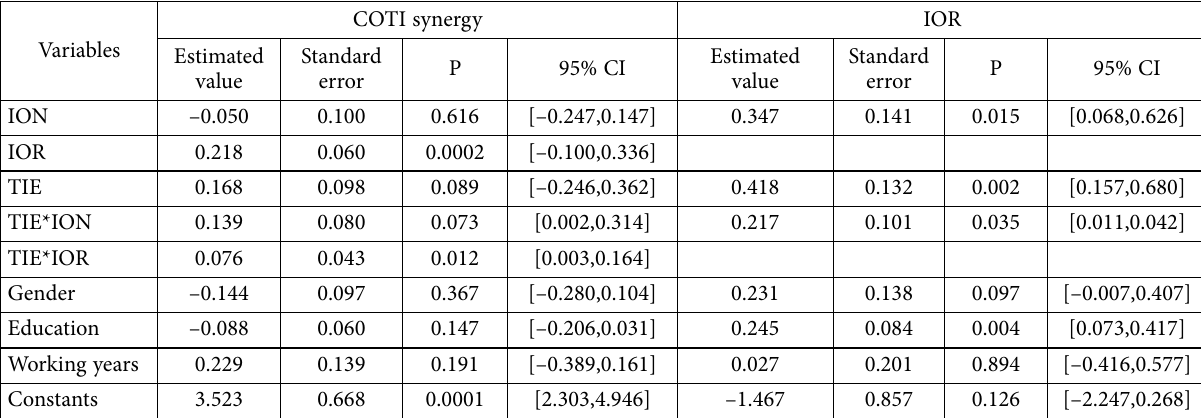
Table 4. Regression analysis results for the moderating effects